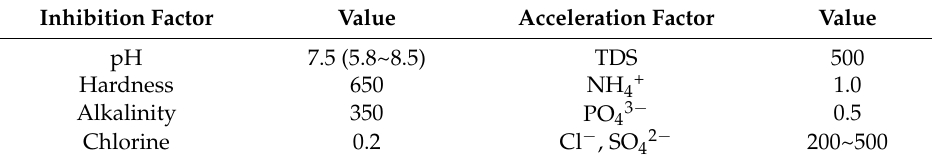
Table 9. Optimizing factors of corrosion control for